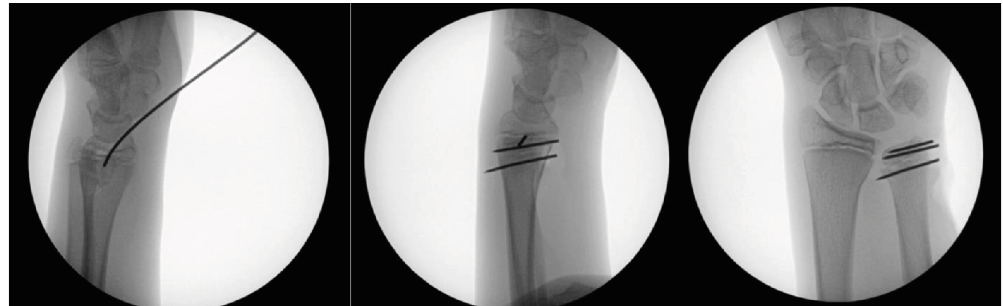
Figure 2: Radioscopic control of pin placement during